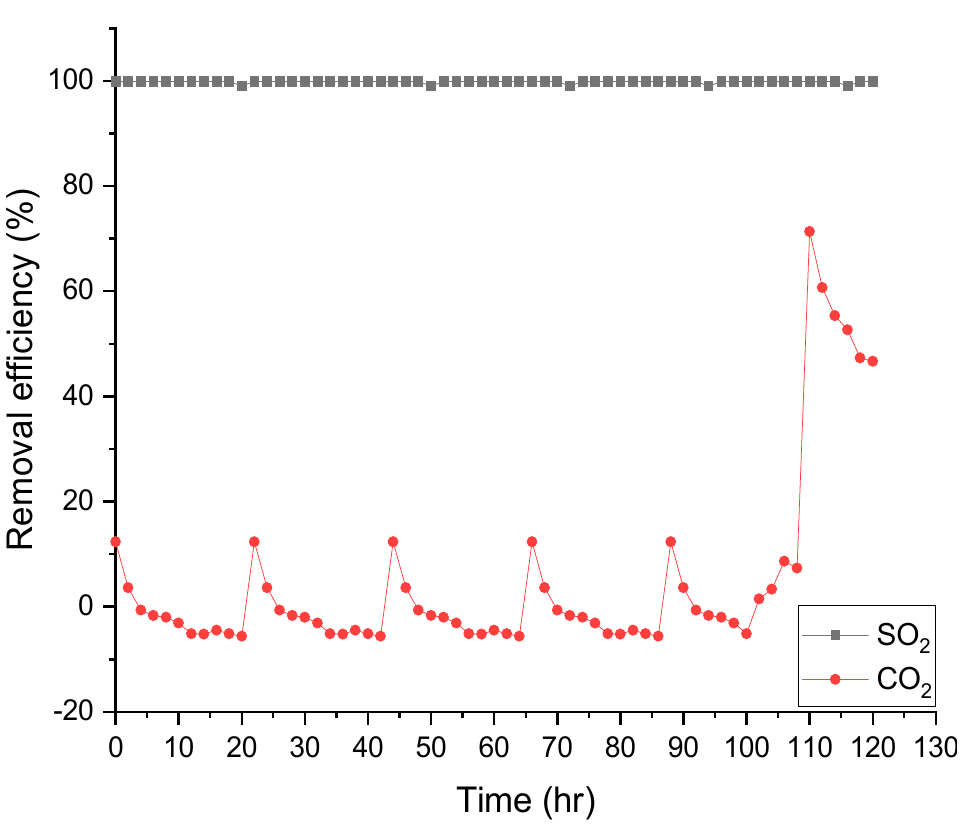
Figure 5. The lines marked with a black square symbol and a red circular symbol line indicate the SO 2 and CO 2 removal efficiencies, respectively. The transition point occurring in the graph indicates the replacement time of the used absorbent.